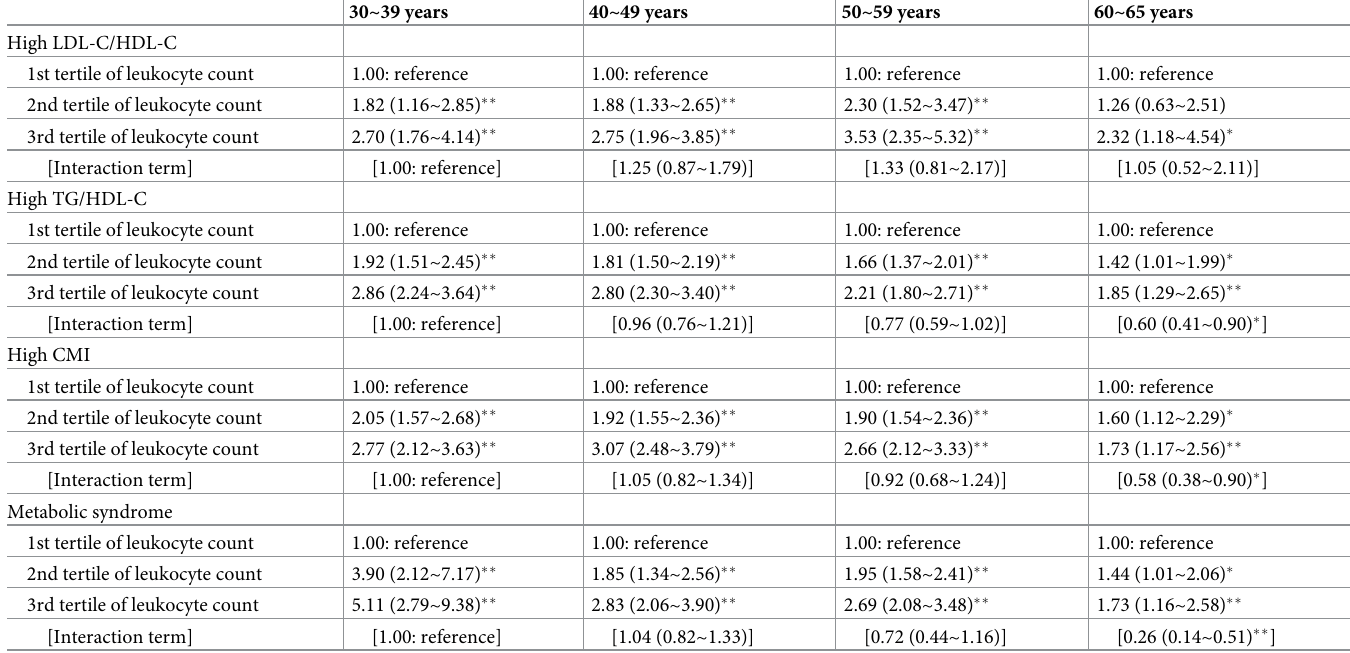
Table 8. Odds ratios for each cardiometabolic risk factor of the 2nd and 3rd tertile groups vs. the 1st tertile group of leukocyte count in different age groups of over- all